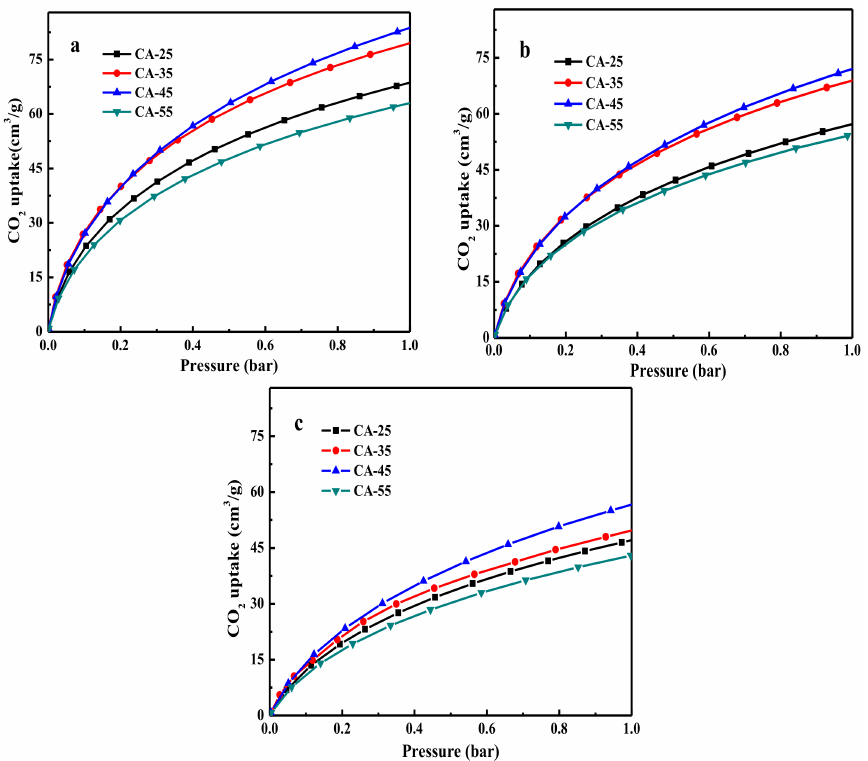
Figure 6. Adsorption isotherms of CO 2 at ( a ) 0; ( b ) 12.5 and ( c ) 25 ◦ C over CA-X